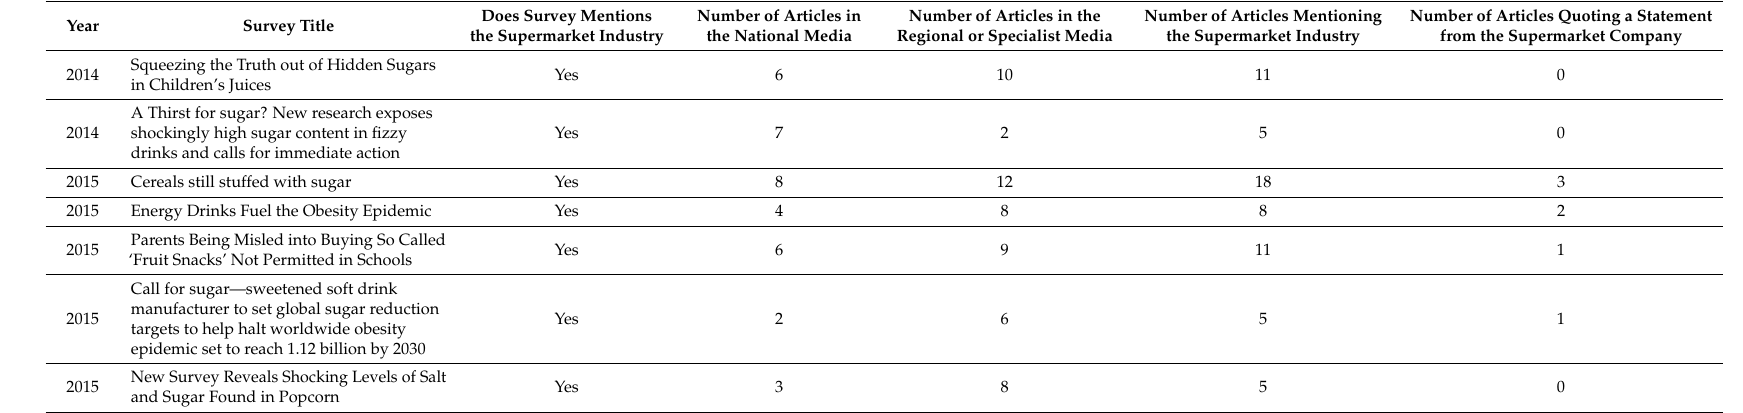
Table 3. Mentions and Statements of Supermarkets in Media Articles following Surveys from Action on